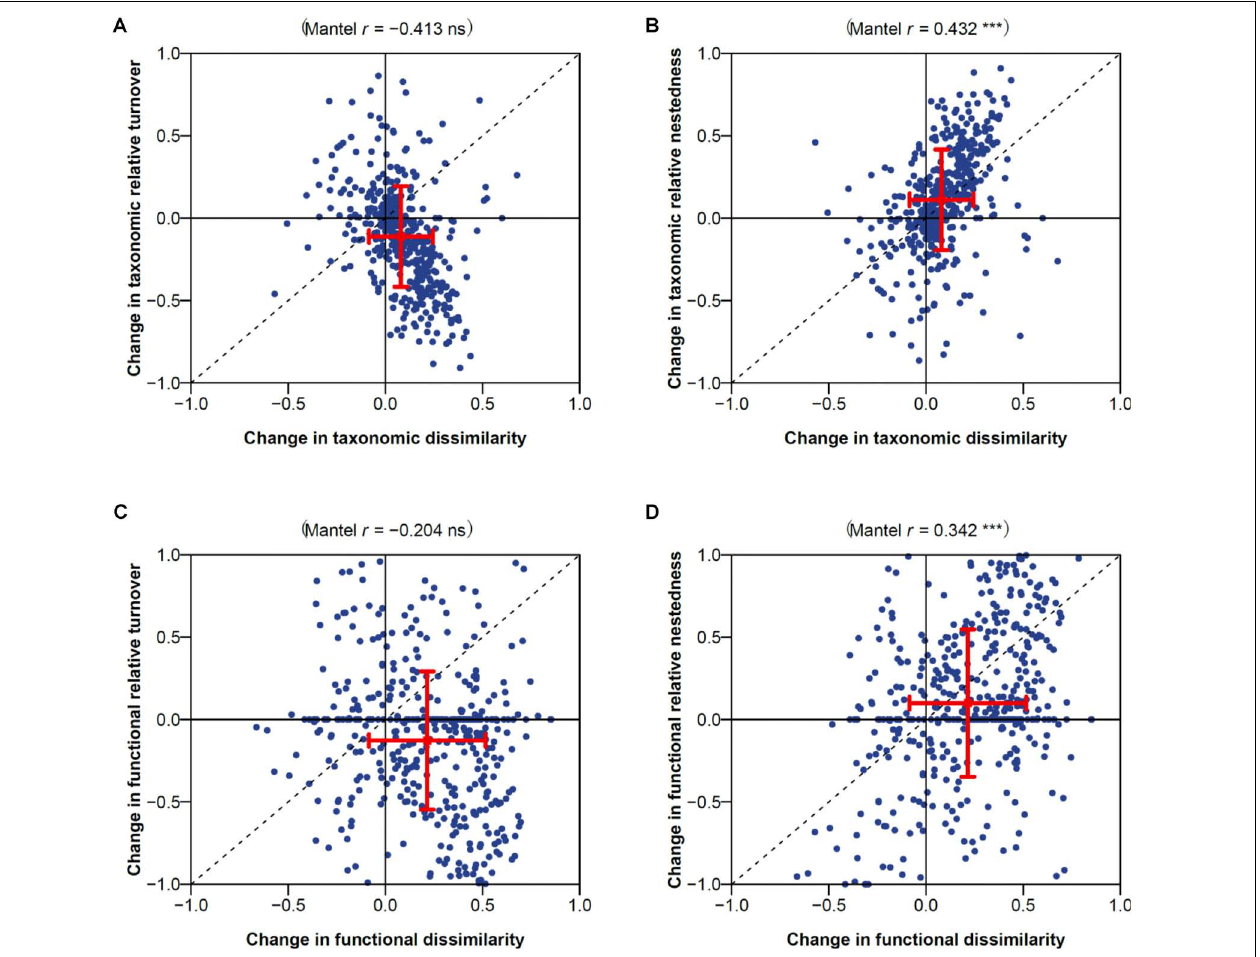
FIGURE 2 | Changes in (A,B) taxonomic and (C,D) functional dissimilarity vs. changes in contribution of (A,C) turnover and (B,D) nestedness to dissimilarity. Spearman’s correlation coefficient and associated Mantel permutation test are provided at the top of each panel ( ∗∗∗ P < 0.001; ns, not significant). The mean value and associated standard deviation among macrophyte assemblage pairs is shown in each